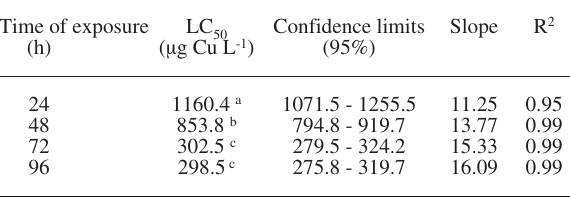
Table 1. – Parameters of acute lethal toxicity bioassays for Zoea I of Lithodes santolla exposed to copper. Same superscript letters indicate homogeneous group ( p >0.05)